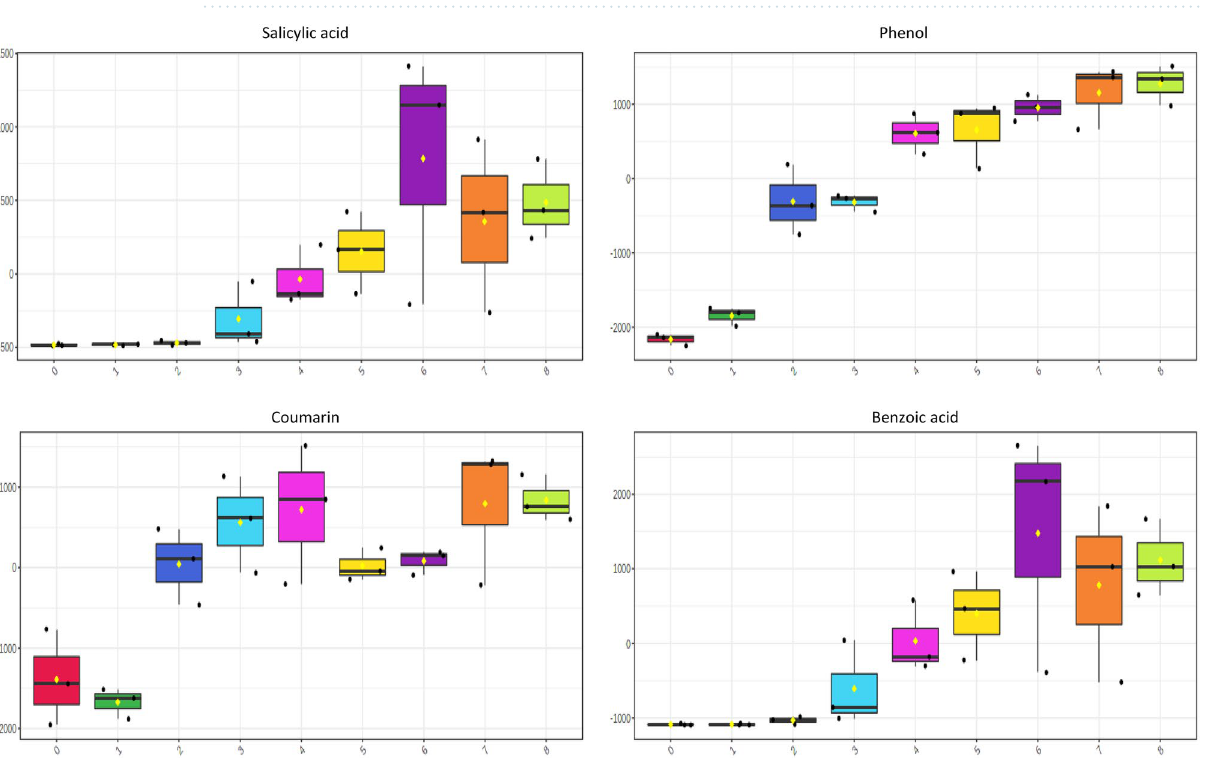
Figure 8. Box plots of metabolites linked with undesirable cocoa sensorial notes with significant differences throughout fermentation days (one-way ANOVA correcting for false discovery rate, FDR). Salicylic acid (phenolic, faint), phenol (phenolic), benzoic acid (urine, faint), coumarin (green,